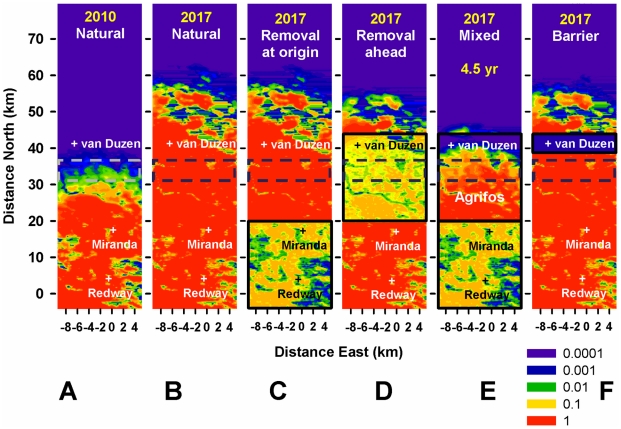
Alternative treatments initiated in 2010 in areas smaller than the cryptic epidemic.Risk maps showing probability of infection (cryptic and symptomatic) on logarithmic scale (red∼1, yellow∼0.1, green∼0.01, blue∼0.001, violet≤0.0001). In 2010 the epidemic front is 31–38 km from the origin (broken lines, c.f. Fig. 3). A–B) 2010 and 2017: natural spread. C–F) 2017: controlled spread – all treatments fail to contain the front and protect the Target area from invasion; the delay in invasion is indicated (top) where ≥1year. C) Removal at the origin (Area 1, thick black line, c.f. Fig. 2D) – the front is not delayed significantly (c.f. Fig. 1C); local inoculum is kept at a low level but is not eliminated due to the 2–3 year delay in detecting cryptic infection and removing inoculum, host re-colonization after removal, and re-infection from non-controlled-areas (c.f. Fig. 1D). D) Removal ahead of the origin (Area 2) – the front is also not delayed significantly. E) Mixed strategy: host protection (Agri-Fos®) ahead of the origin and removal at the origin – the protection initially extends beyond the epidemic front and delays it (speed∼1 km/year, Fig. 3B), but as protection is partial and wanes, this “barrier” thins (c.f. A) and is overcome by long-distance dispersal (c.f. Fig. 1E). F) “Host-free barrier” 5 km thick, 35 km from Redway, is overcome by long-distance dispersal (c.f. Fig. 1E).